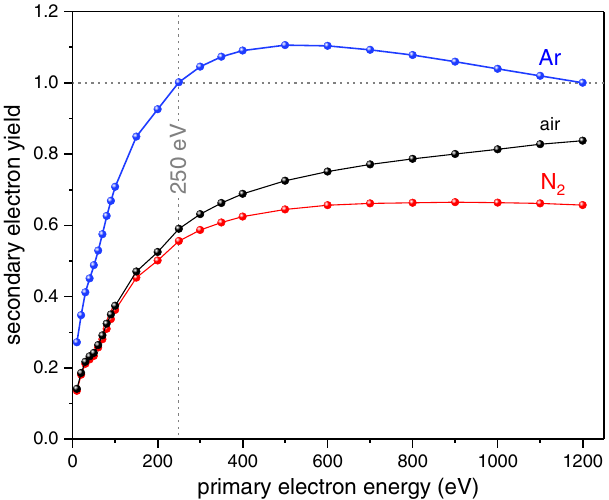
FIG. 6. Room-temperature SEY results of LH-patterned Cu samples treated in nitrogen (red line), argon (blue line), and air (gray line). The results are the average of three measurements at different locations at the sample. The energy for which the SEY increases above unity is indicated.